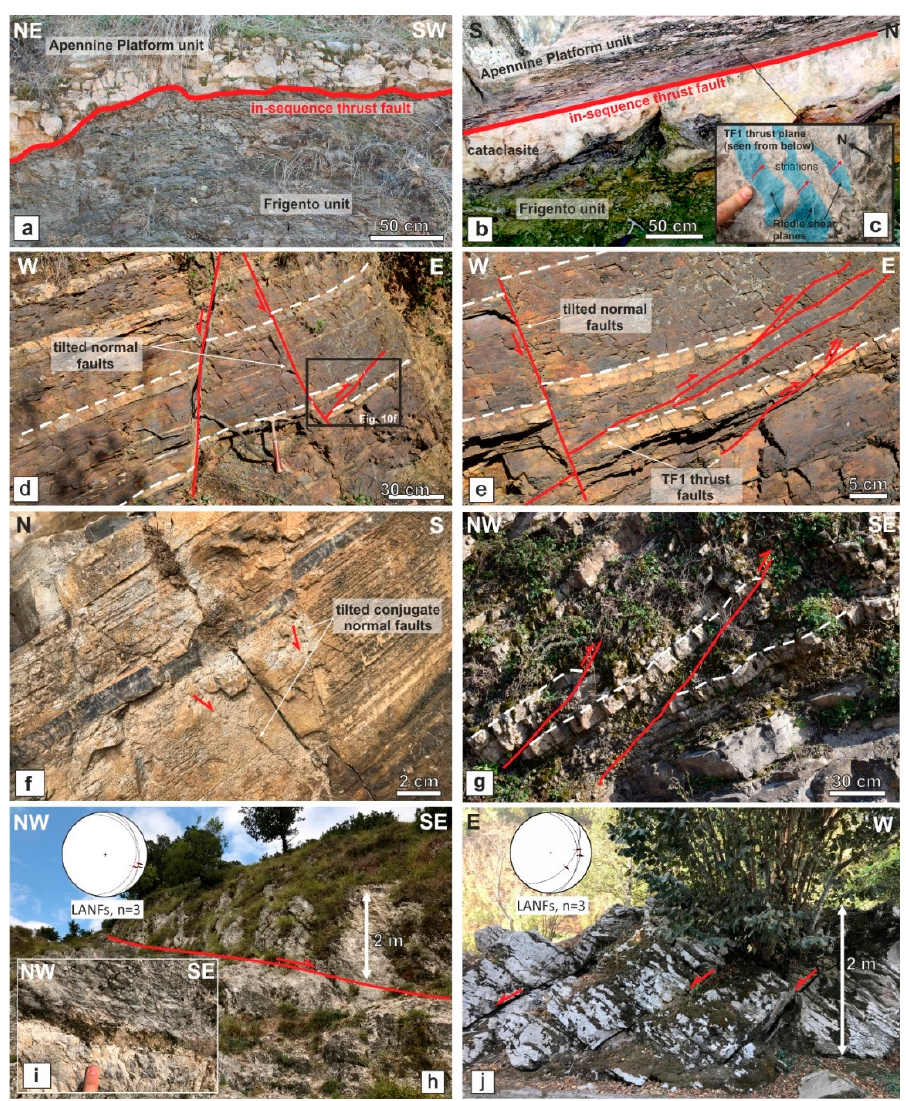
Figure 10. Giffoni tectonic window. ( a , b ) in-sequence thrust (TF1) between the Apennine Platform unit (Triassic dolomites) in the hanging wall and the Frigento unit (Scisti Silicei Fm) in the footwall (Prepezzano). ( c ) Riedle shears crosscutting the TF1 thrust fault plane. Frigento unit (Scisti Silicei Fm): ( d,e ) tilted conjugate normal faults (NF2) crosscutting thrust faults (TF1) (Prepezzano). ( f ) Tilted conjugate normal faults (Sieti). ( g ) Minor thrust faults (TF1) in Calcari con Selce Fm (Giffoni Valle Piana). ( h ) LANF in Rhaetian–Jurassic dolostones (Giffoni Valle Piana). ( i ) Fault gauge associated with the LANF of the previous picture. ( j ) minor LANFs in Carnian well-bedded limestones (Prepezzano).